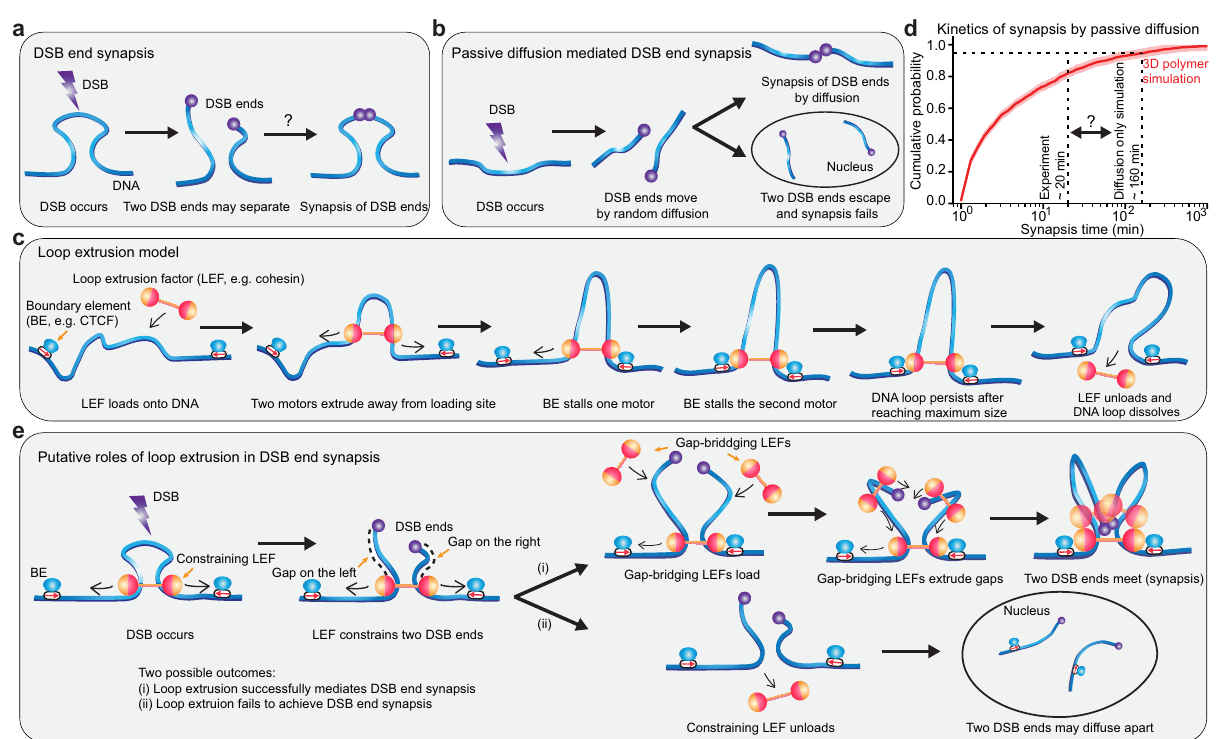
Fig.1|AmodelofDSBsynapsis,mediatedbyDNAloopextrusion.a AfteraDSB has occurred, the two DSB ends may separate. How the two DSB ends are con- strained from diffusing too far apart and brought back into proximity for down- streamrepair is not well understood. b Overviewof DSBend synapsismediatedby passive diffusion. c Overview of the loop extrusion model. Loop extruding factors (LEFs) extrude bidirectionally away from the loading site; the two motors of a LEF extrude independently: after one motor is stalled by a boundary element (BE), the othermotorcancontinueextrudinguntilencounteringaBEontheotherside. d 3D polymer simulation reveals a large discrepancy between the kinetics of synapsis mediated by diffusion alone and the synapsis kinetics determined experimentally. The shaded area around the cumulative probability curve (calculated from 2223